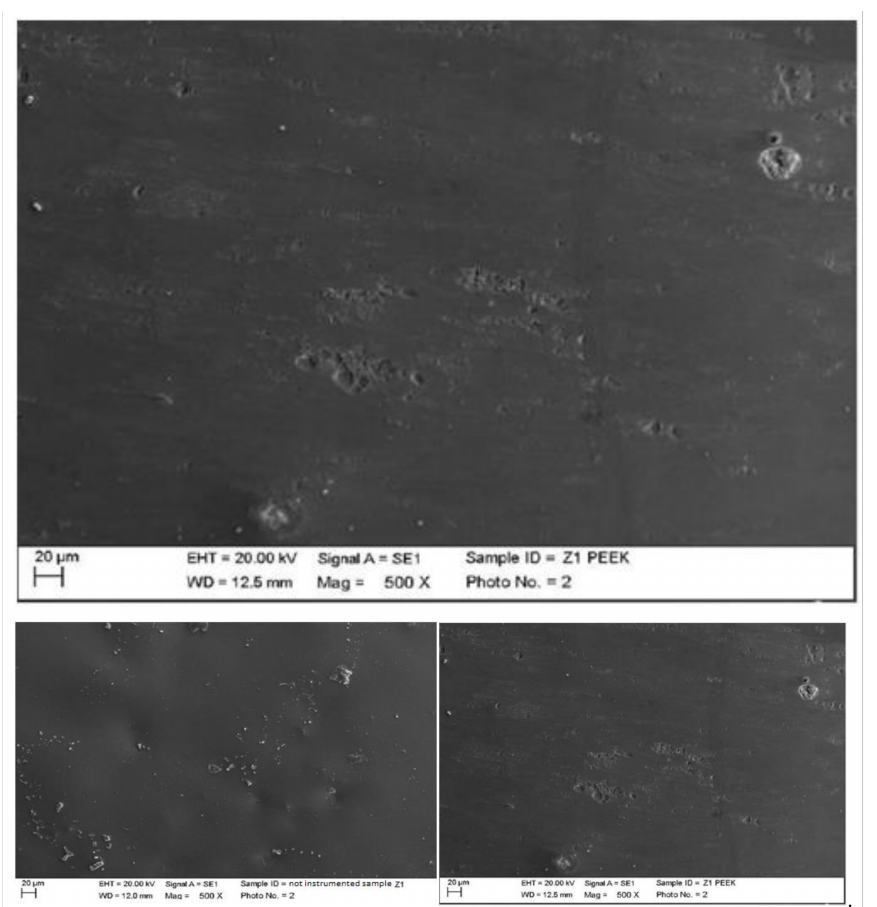
Figure 19. Instrumented zirconium sample Z1 with peek insert (500 × ). Comparison before/after instrumentation.